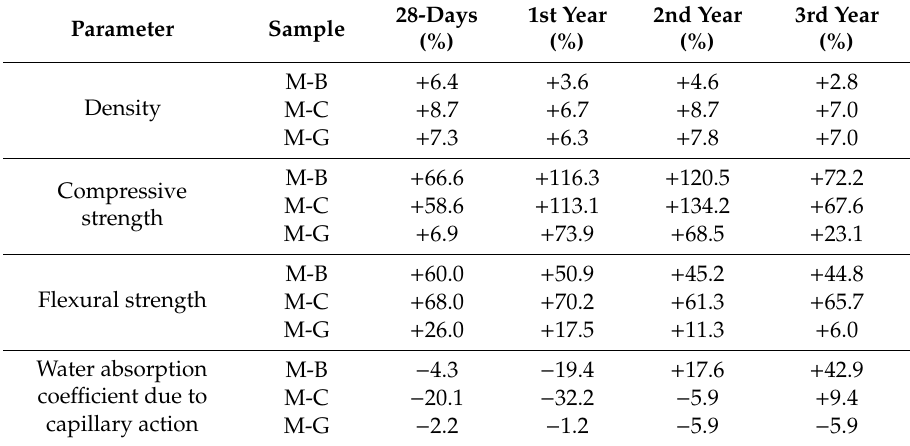
Table 4. Percentage increase ( + ) / decrease ( − ) of property values of micro-fillers-based samples comparing to the control mixture C-M, per